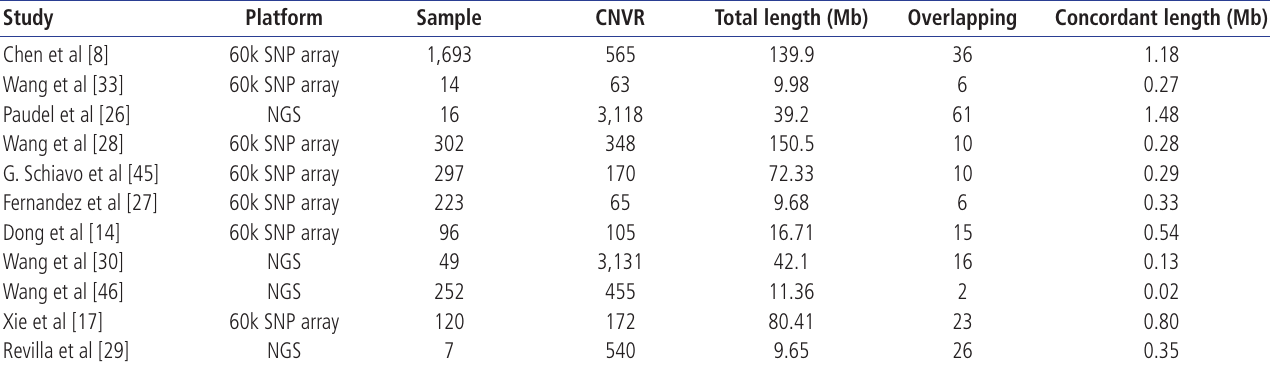
Table 1. Comparison of CNVRs identified in this study with those 11 previous studies Study Platform